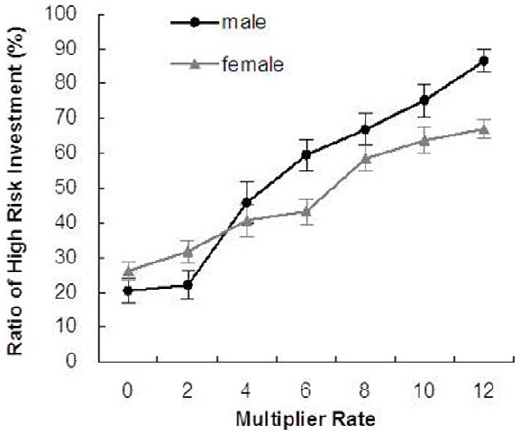
Figure 7. Percentages of high-risk investment ( 30 UEC ) of male and female participants over all trust games. Graphs show the mean 6 SEM.